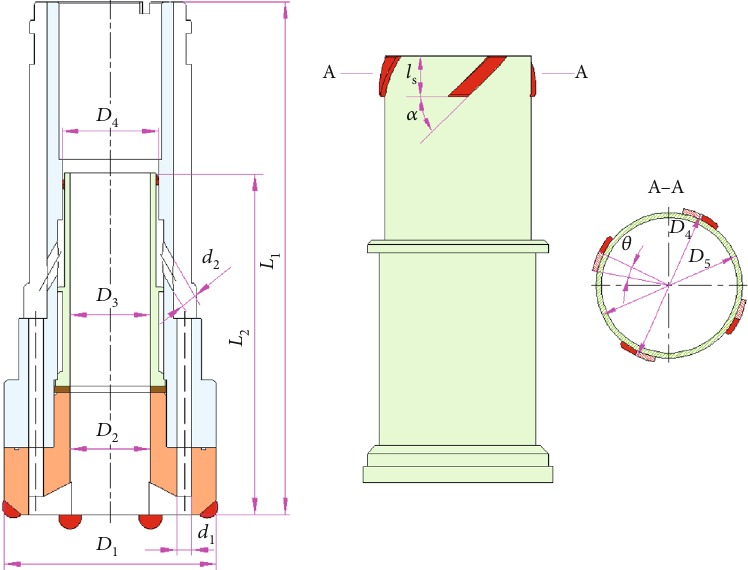
Figure 4: Views of the novel drill bit with a vane swirler inside. Table 1: Structural parameters of drill bit with a vane